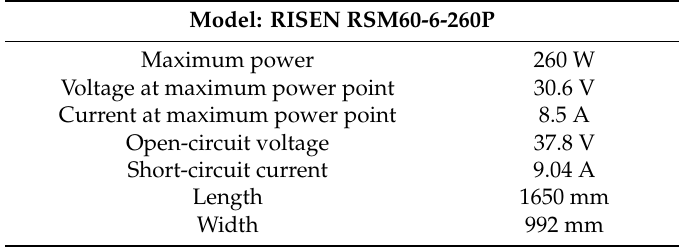
Table 3. Photovoltaic module technical data as supplied by the manufacturer [23].